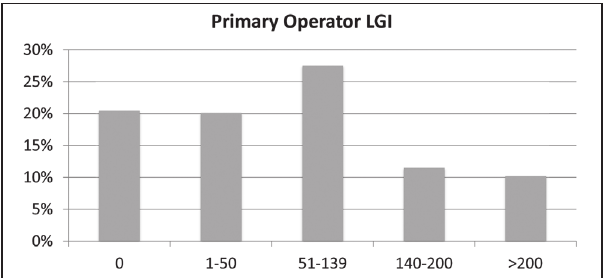
Figure 4) Volume of upper gastrointestinal (UGI) procedures performed by Canadian surgical residents across all years of training. Adapted with per- mission from the Canadian Association of General Surgeons Residency Committee Survey